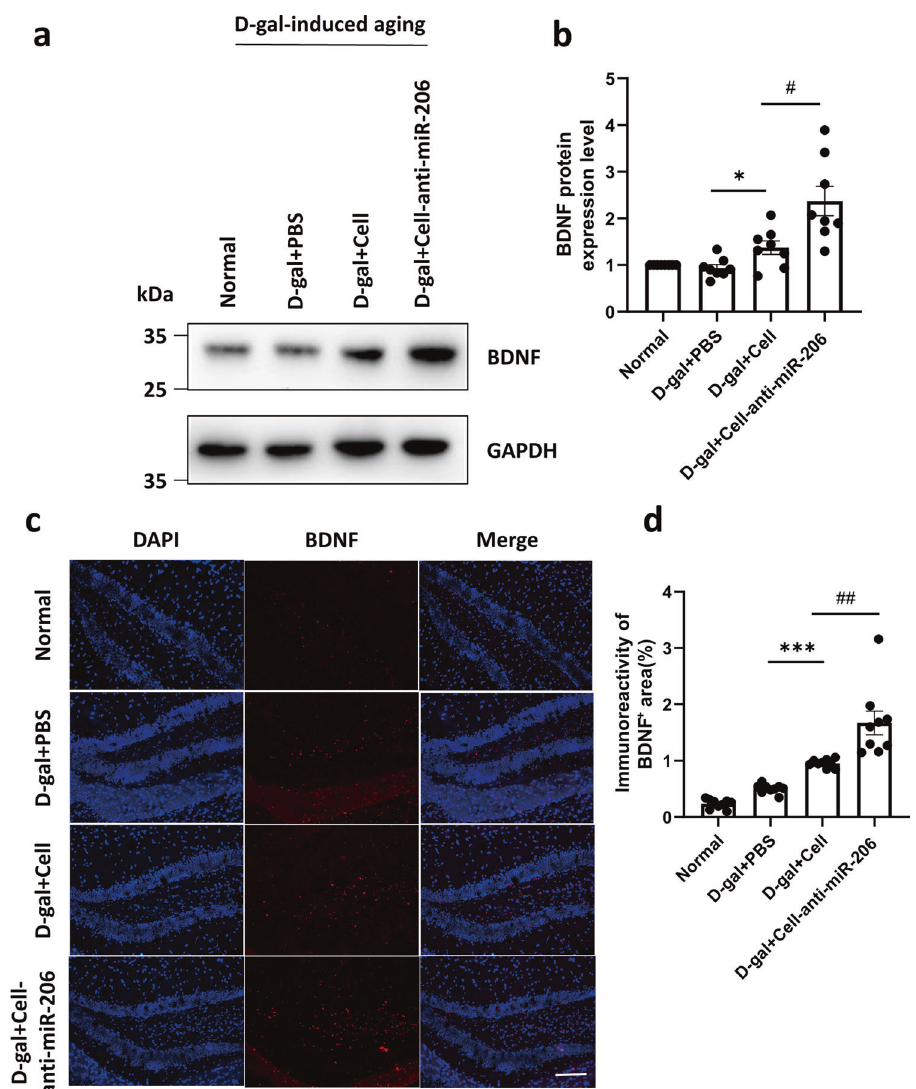
Fig. 5 The low expression of miR-206 in hUCMSCs promoted the expression of BDNF in vivo. a The protein levels of BDNF were determined by western blotting. b Quantitative analysis of the protein levels of BDNF using ImageJ. c Representative micrographs for BDNF immuno fl uorescence staining of hippocampus from mice in four groups ( n = 5 per group). d Quanti fi cation of BDNF-positive cells in four groups. The results were expressed as the Mean ± SD, * p < 0.05, n.s., nonsigni fi cant, bar = 50 µm, n =